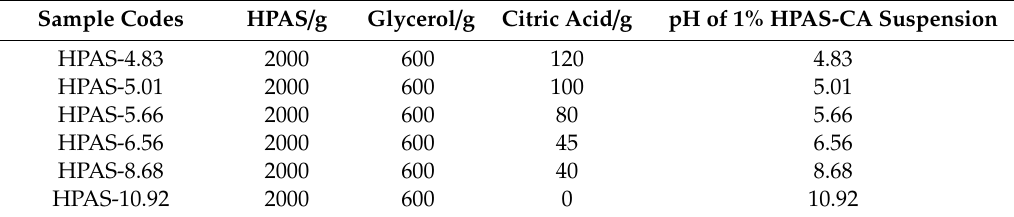
Table 1. Sample codes and relevant sample